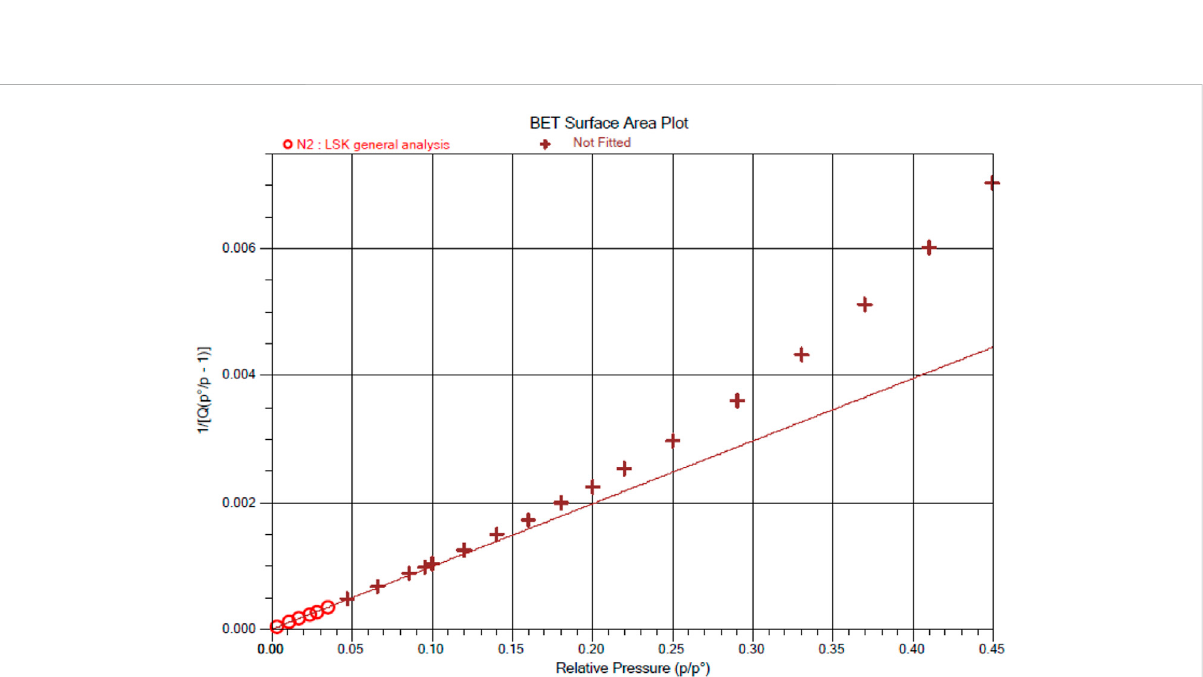
FIGURE 7 BET surface area plot of Ce-MOF representing surface area, slope: Y-intercept, and correlation coef fi cient.